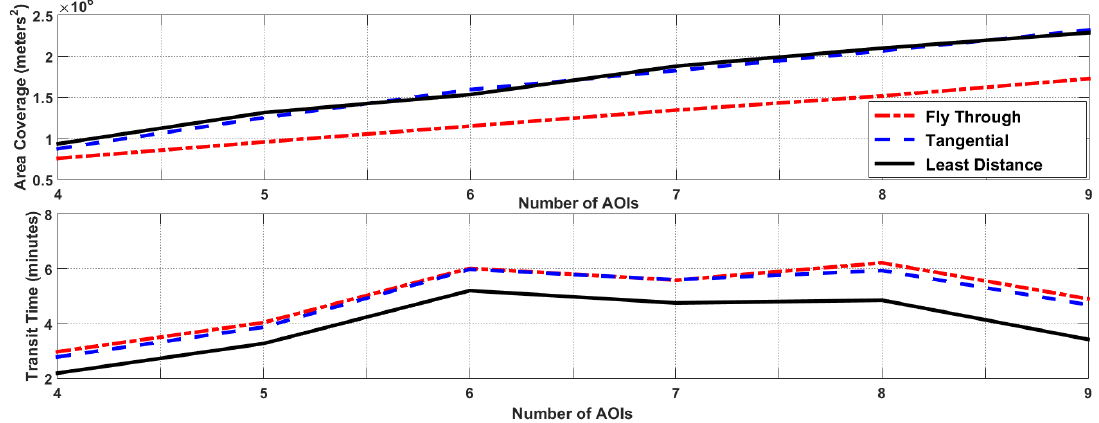
Figure 14. Comparison of fly through, tangential smart loiter, and least distance loitering